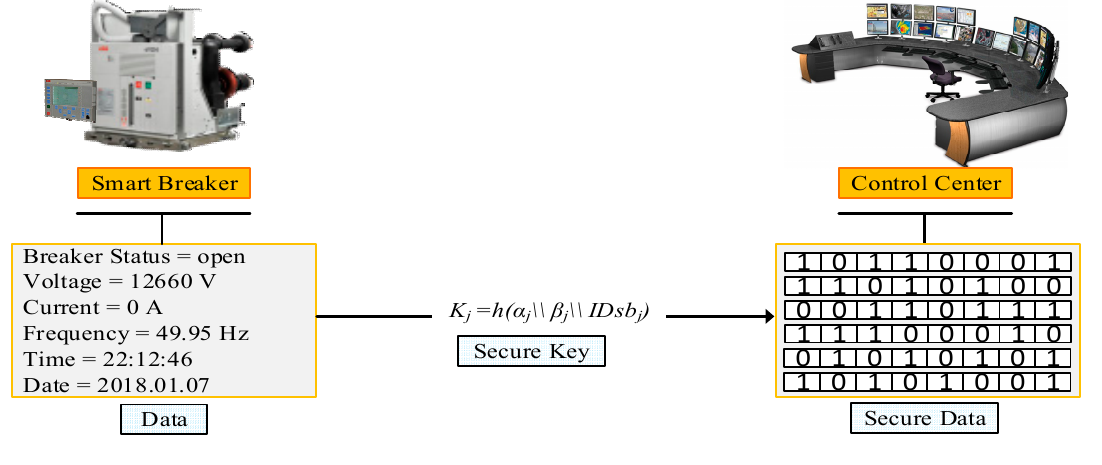
Figure 6. Key Session from the SB to the CC.